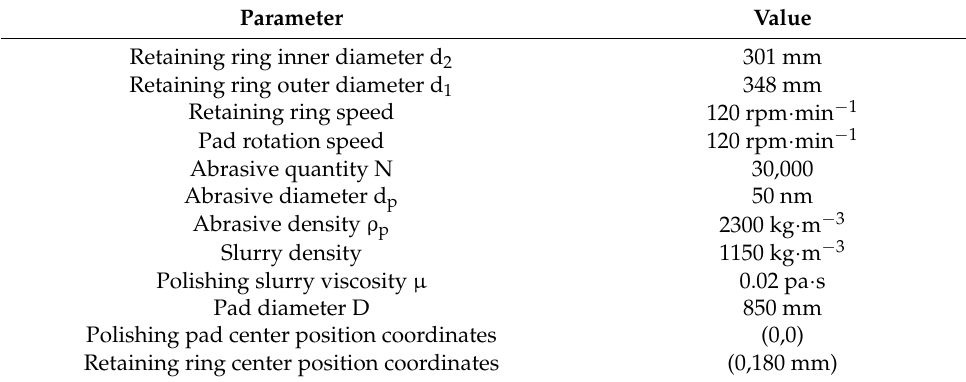
Table 2. Simulation scheme for retaining ring groove